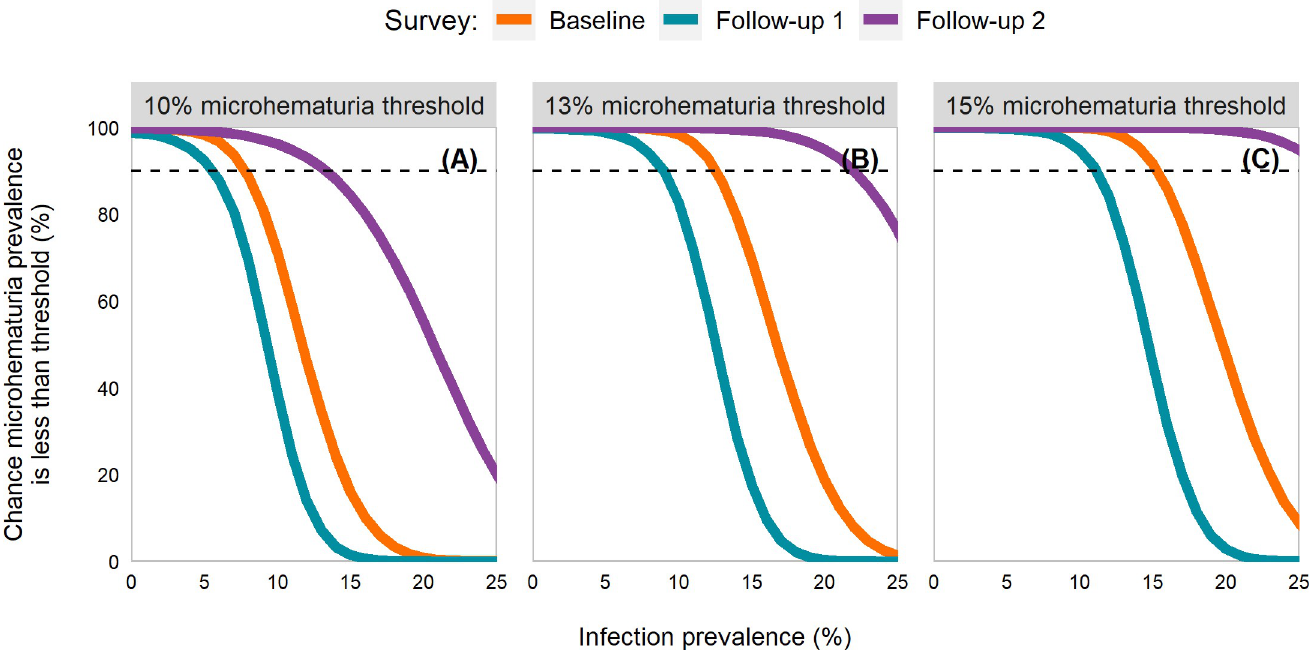
Fig 2. Line plots by survey of the percent chance a school with a given Schistosoma haematobium infection prevalence is below the microhematuria threshold. Panel A is for a 10% microhematuria threshold; panel B for 13%; and panel C for 15%. Estimates utilized children aged 6–15 years from Burkina Faso, Mali, Niger, Tanzania, and Zambia participating in schistosomiasis control program activities between 2003 and2008. Full description of the methods is in S1 Text. The dashed line indicates a 90% chance of being below the threshold.